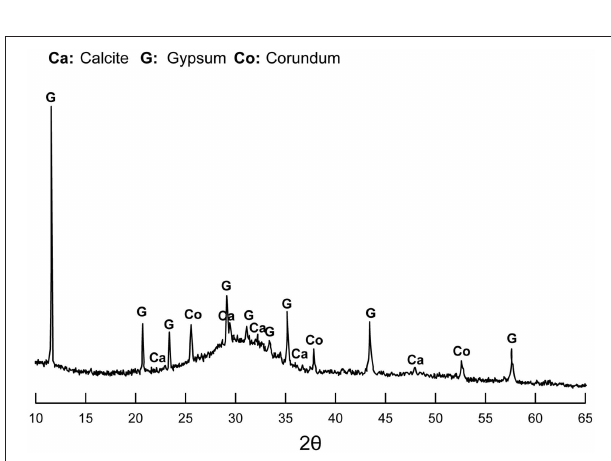
FIGURE 3 | X-ray diffraction analysis of slag. (Note: The corundum was added as internal standard for quantitative analysis).